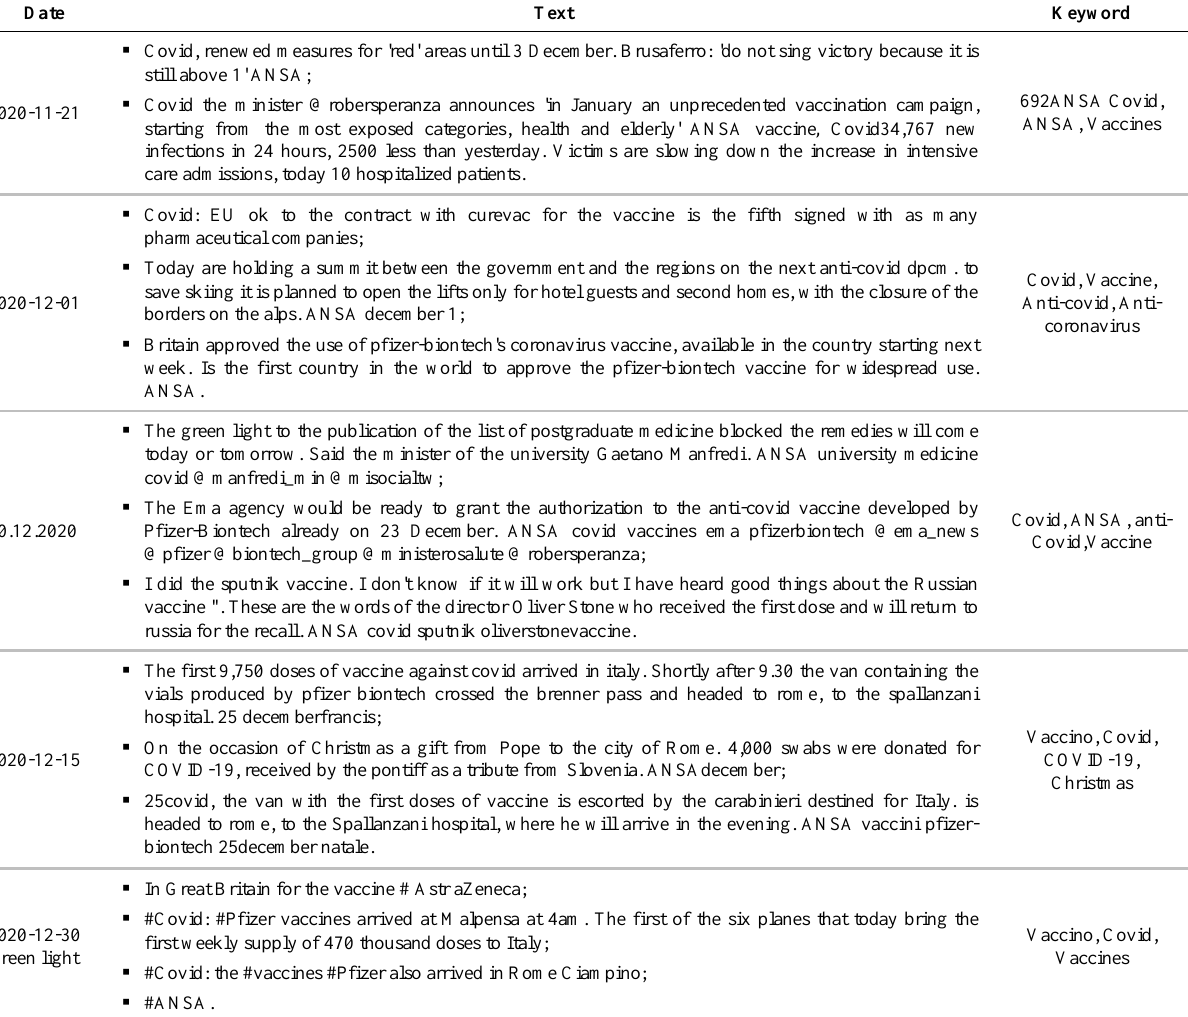
Table 8. Main news related to postive peaks